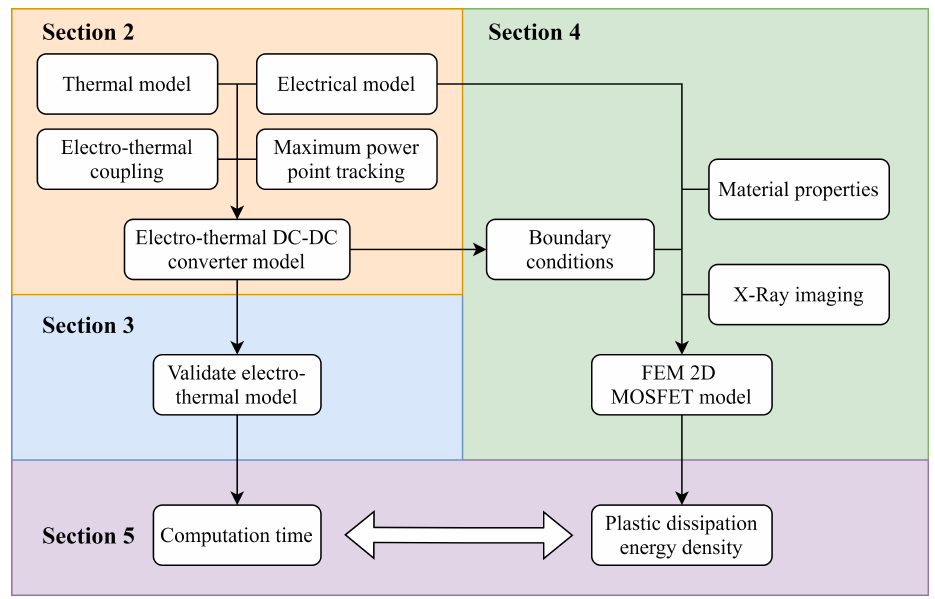
Figure 2. Flowchart of the paper methodology and